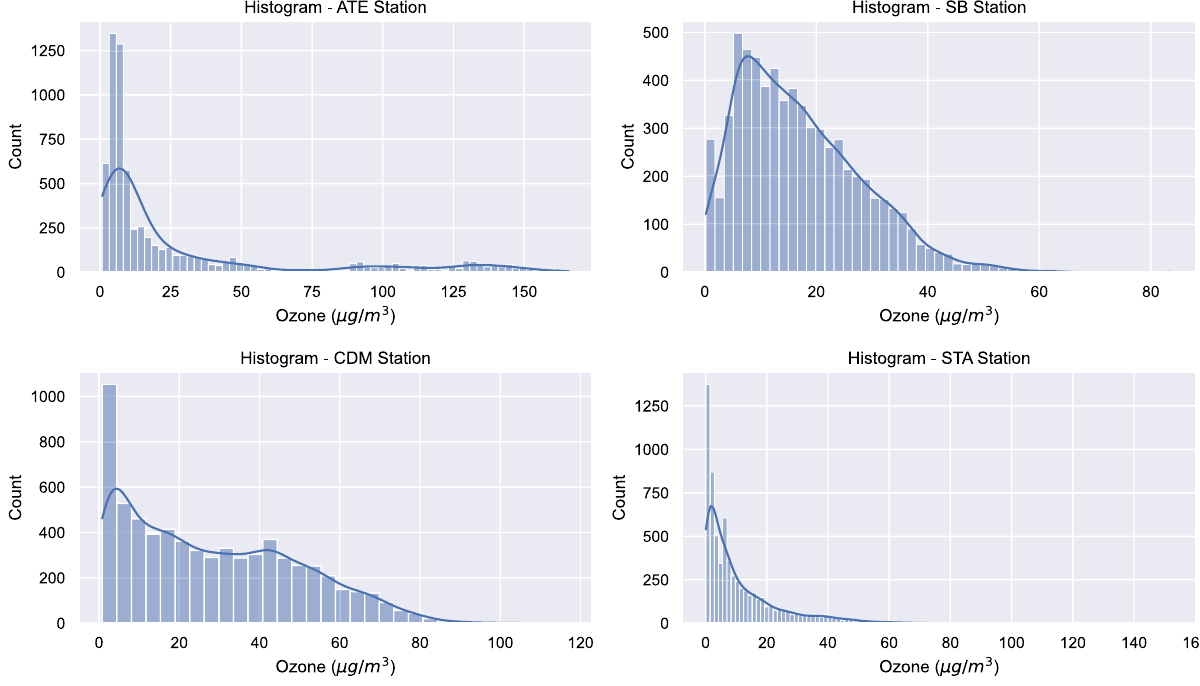
Figure 4. Ozone histogram per each monitoring station. This analysis shows how the ozone behavior is in the different monitoring stations. Likewise, it is complemented with the descriptive analysis, provided by Table 2, where it reports positive asymmetry for all seasons.